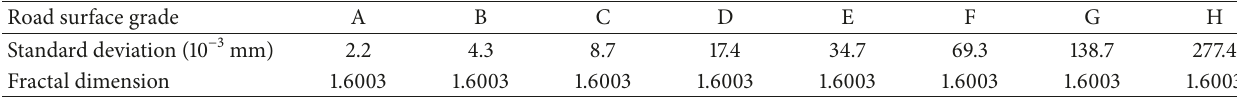
Table 1: Fractal dimension and standard deviation of standard pavement